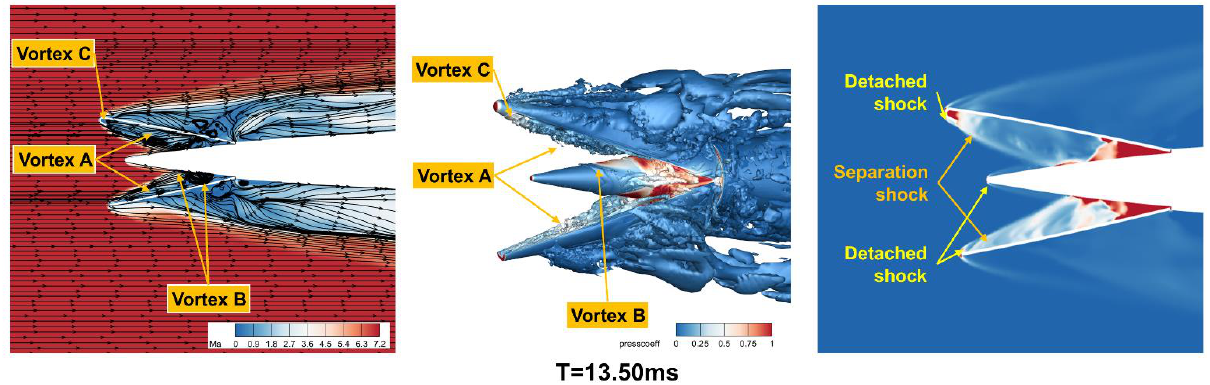
Figure 20. The contour of the streamline and Mach number ( left ), iso-surface of Q-criterion ( middle ), and the contour of the pressure coefficient ( right ) at T = 13.50 ms.